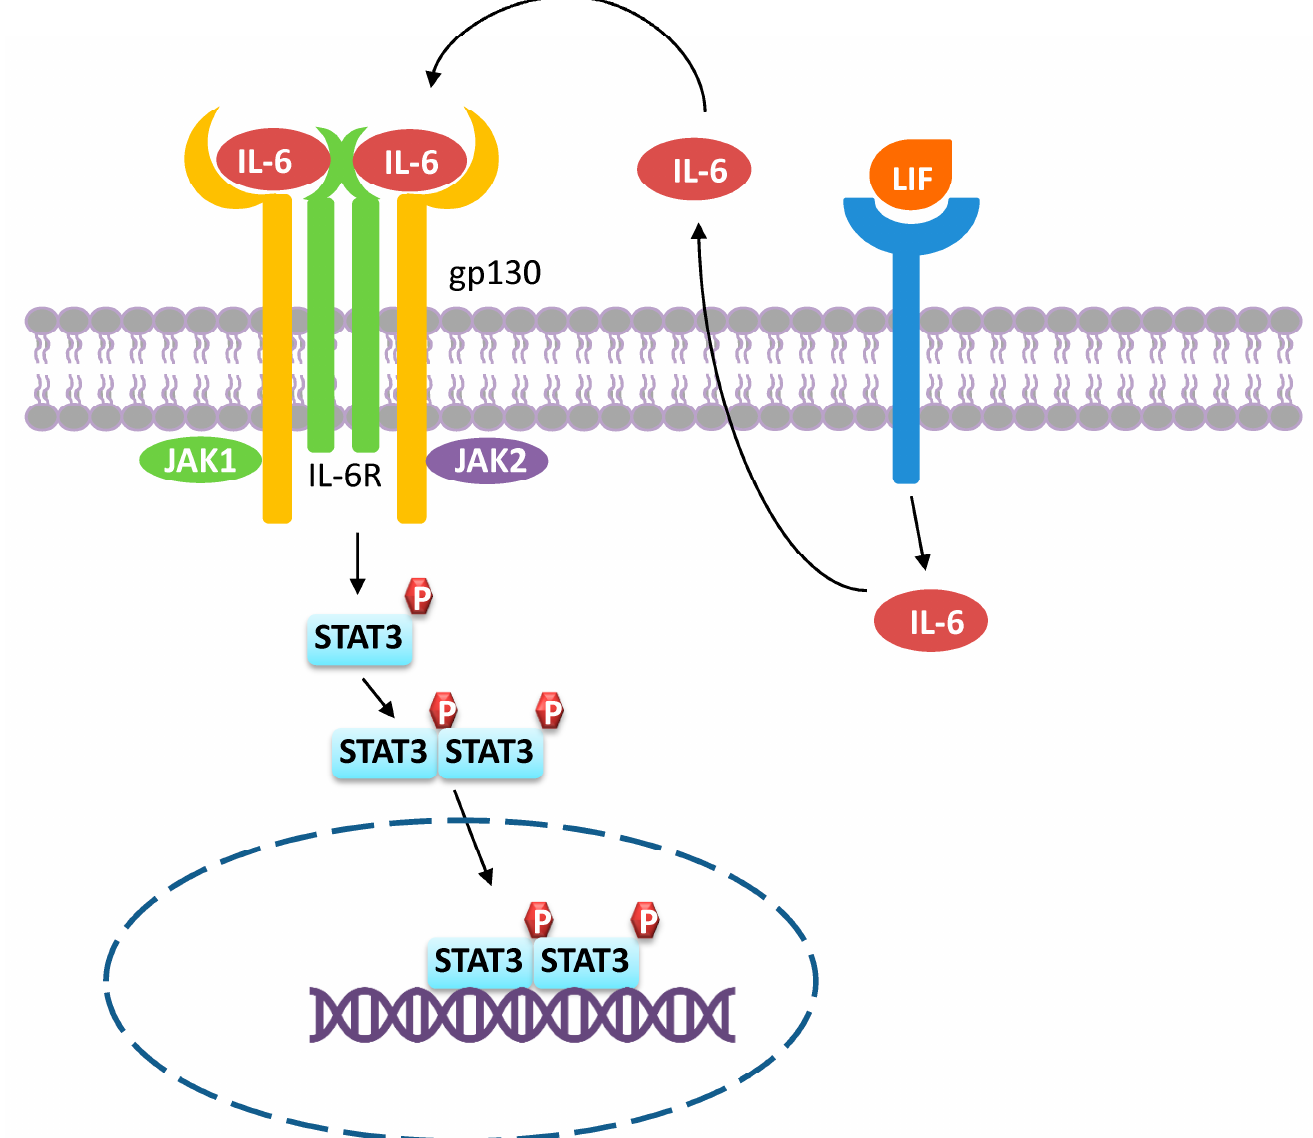
Figure 4. M2d polarization. The binding of IL-6 to the IL-6R/gp130 receptor complex leads to the recruitment of JAK1/2, which in turn phosphorylates STAT3, leading to STAT3 dimerization and translocation into the nucleus, where it activates gene transcription. LIF belongs to the IL-6 family and binding of LIF to its receptor results in IL-6 production. Thus, M2d macrophages can consume IL-6 in an autocrine manner.